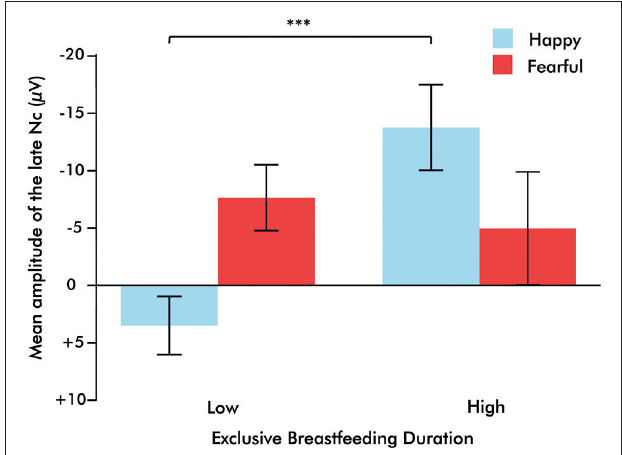
FIGURE 3 | Bar graph illustrating the emotion × exclusive breastfeeding experience (EBF) interaction, in which infants with high EBF duration demonstrate a greater Nc to happiness than to fear, and infants with low EBF duration demonstrate a greater Nc to fear than to happiness . Bars represent standard error of the mean, *** p =